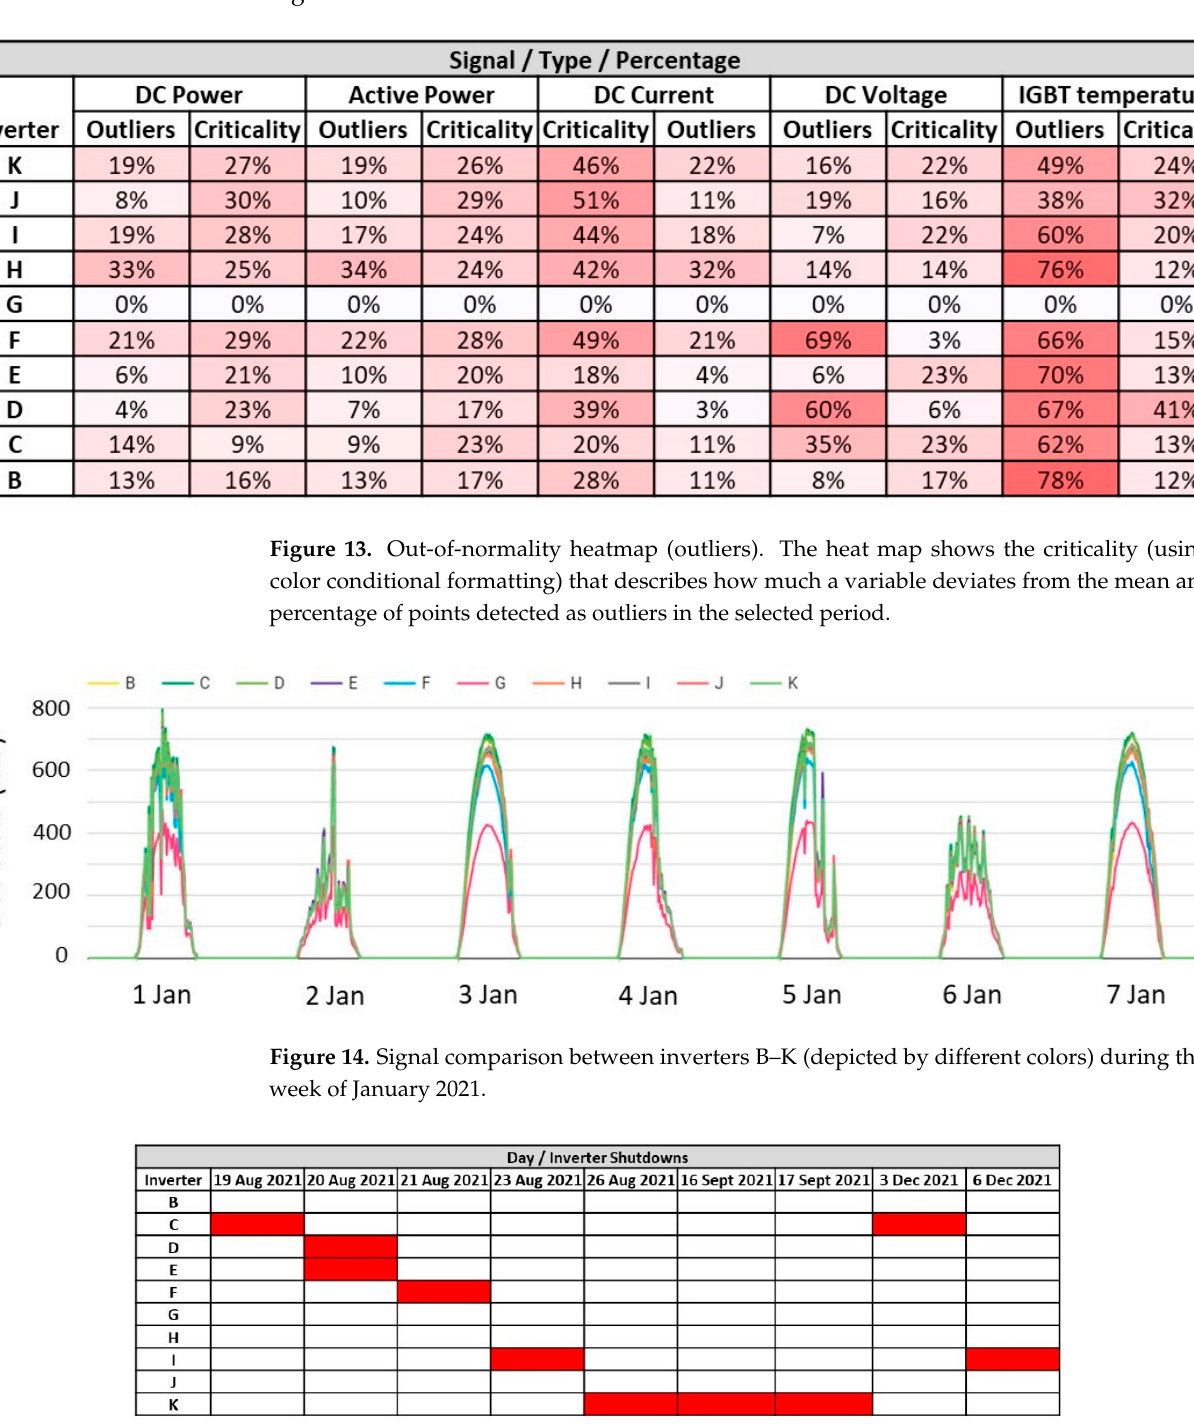
Figure 12. Behavior of signals on the inverter timeline.